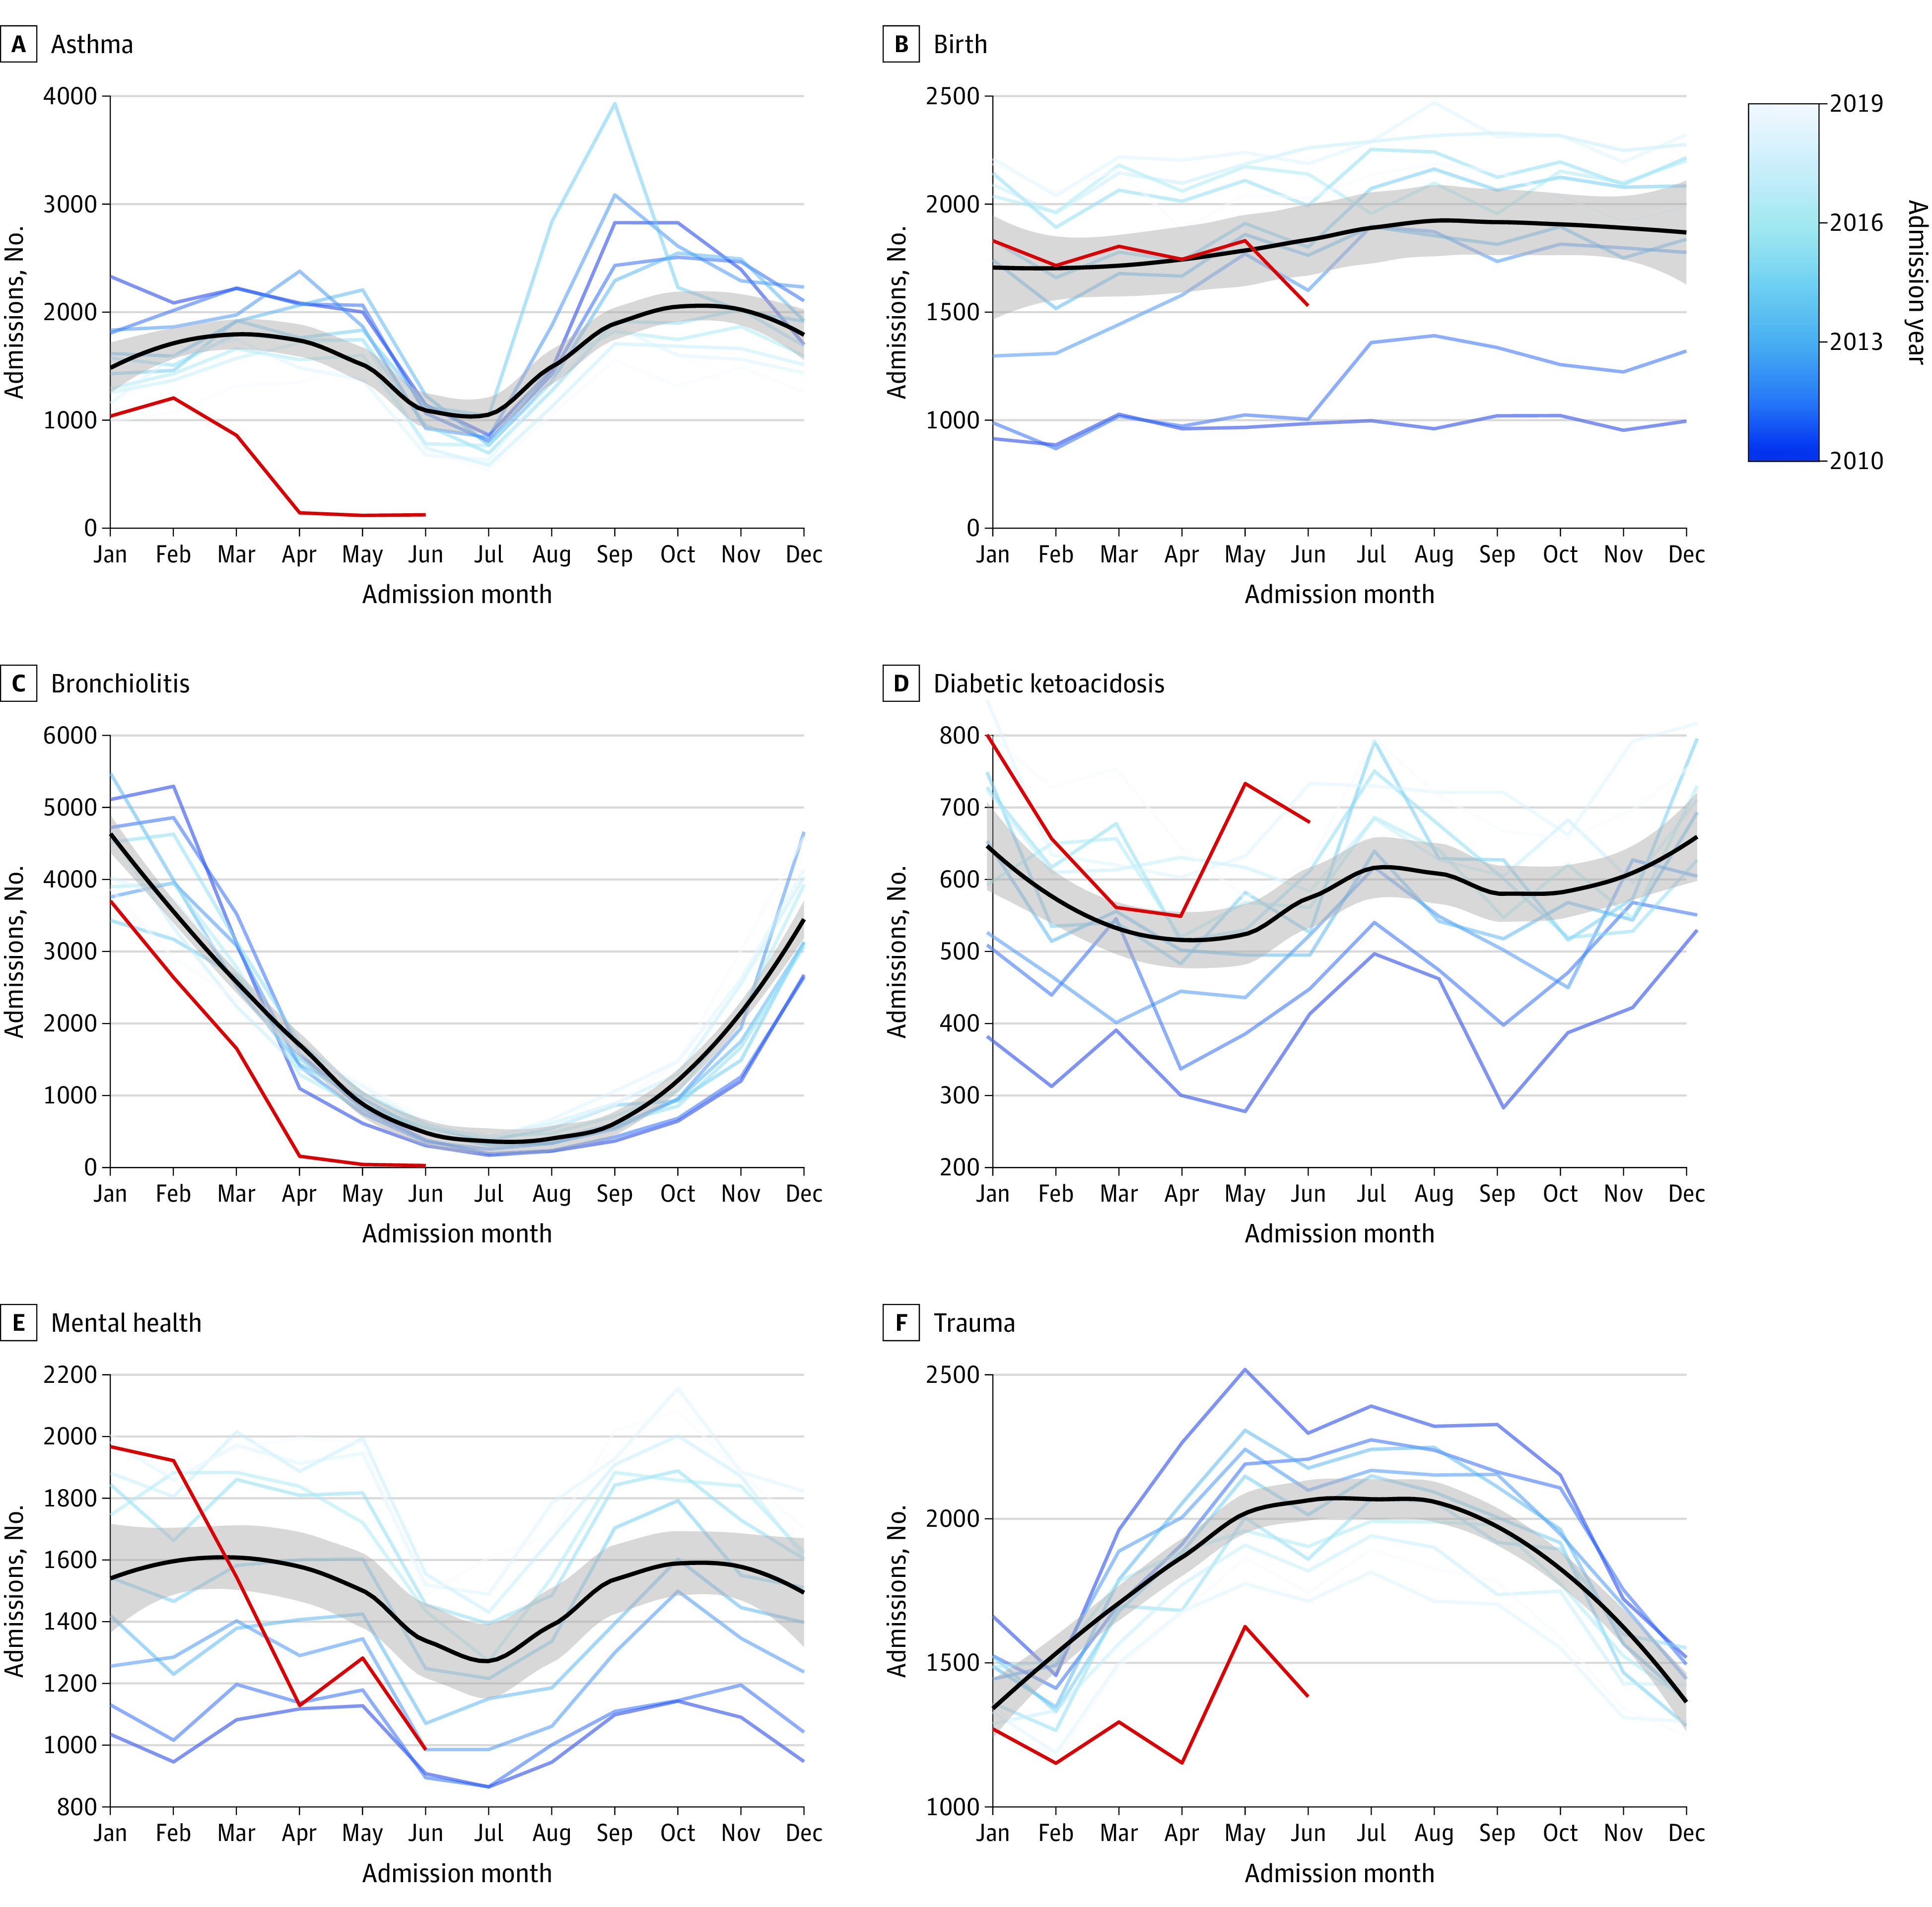
Diagnosis-Specific Monthly Admissions in Pediatric Health Information SystemsEach panel shows the number of monthly admissions for a specified diagnosis between January 2010 and June 2020. Each blue line represents an admission year between 2010 and 2019, with progressively lighter shades of blue representing later years. The black line represents the line of best fit for the data using locally estimated scatterplot smoothing. The gray bar represents the 95% CI of the regression line. The red line shows the number of monthly admissions from January through June 2020.